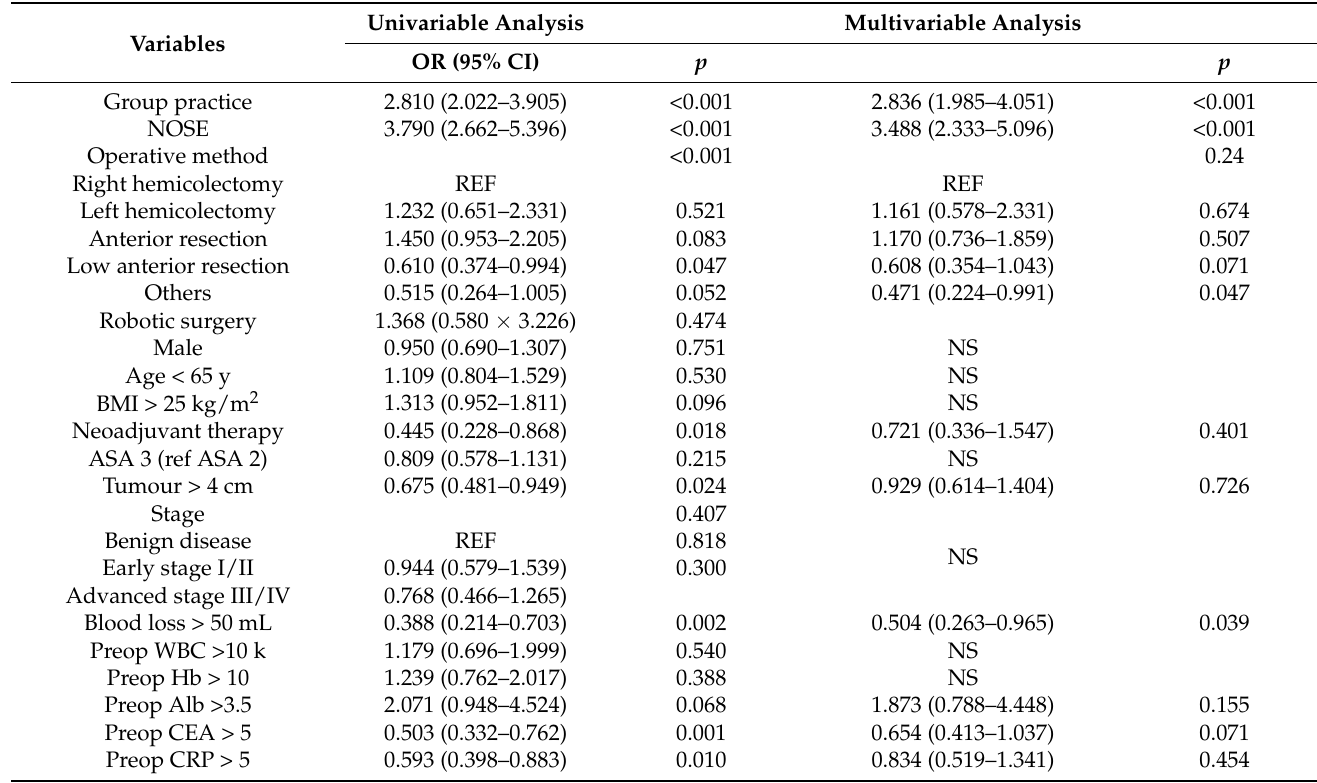
Table 3. Univariate and multivariate analysis of discharge within 5 days postoperatively.